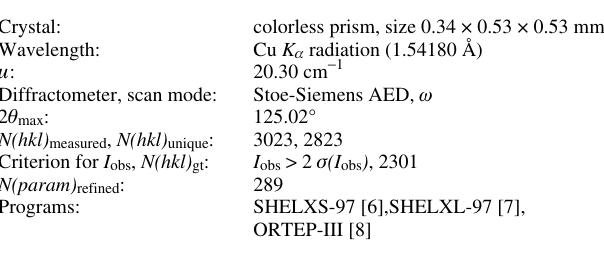
Table 1. Data collection and